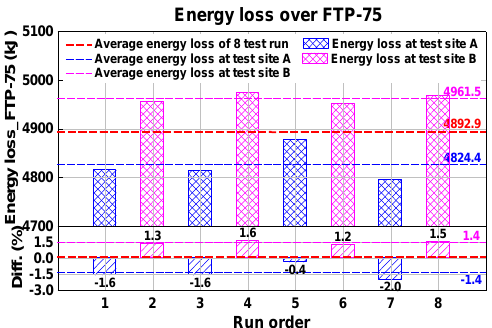
Figure 5. Energy loss and difference graph over FTP-75 test cycle.